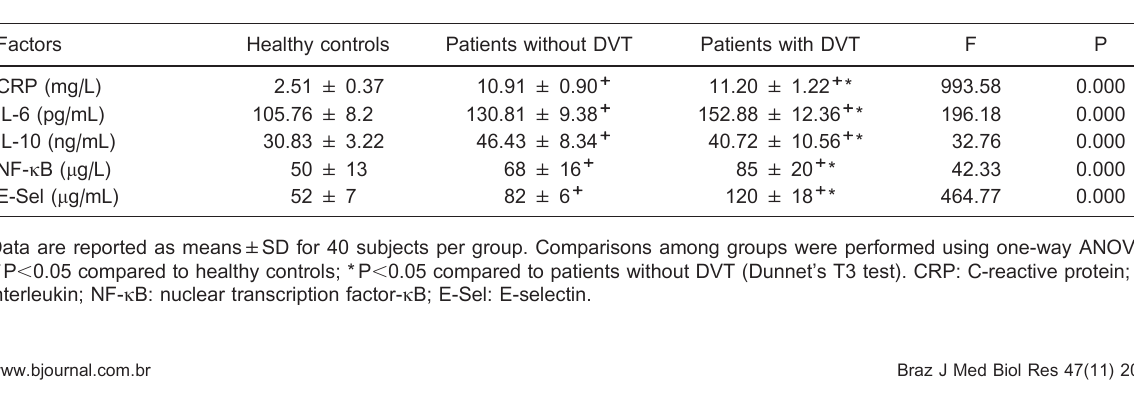
Table 2. Comparison of serum cytokines in patients with and without deep venous thrombosis (DVT) after surgery for an abdominal malignancy and healthy